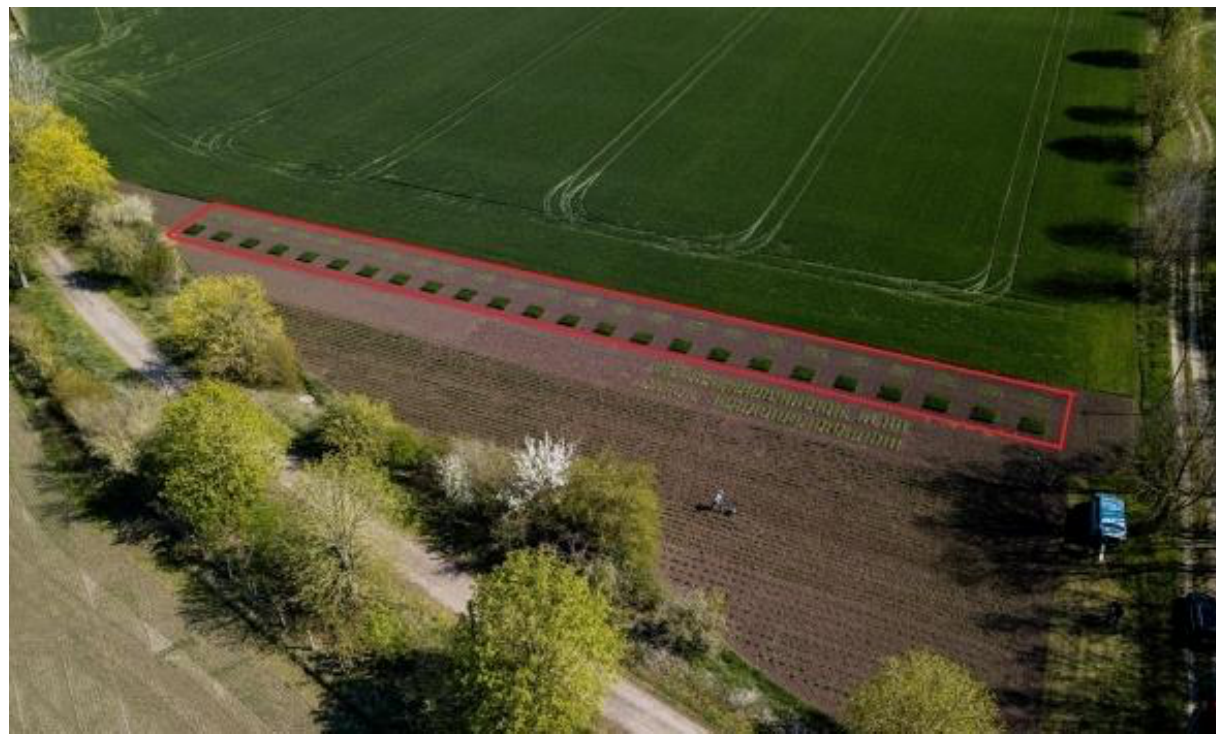
Figure 4. Picture showing the PA-plant composts/ L. squarrosa press-cake experiments. T. aestivum (dark green) and H. vulgare (light green) plots are marked (red box). Each plot represents a different experimental variant or a replicate thereof.